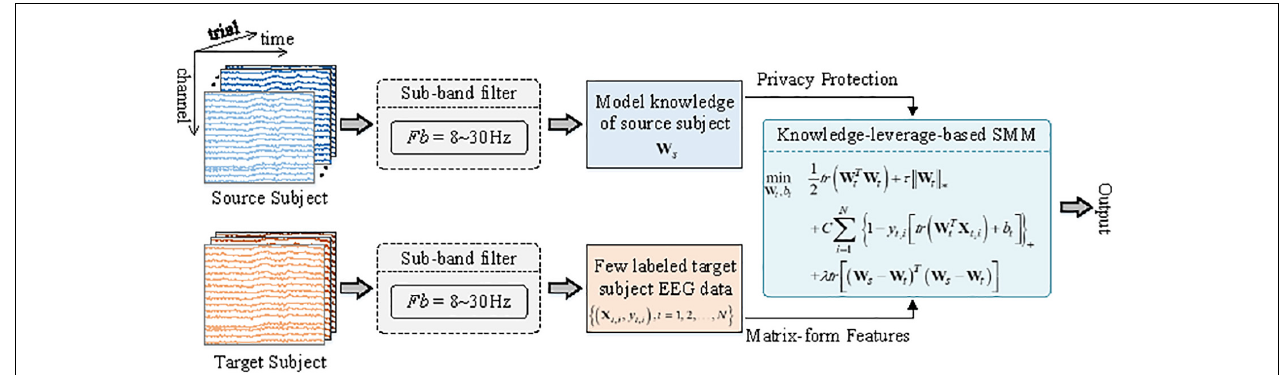
FIGURE 1 | Framework of the proposed KL-SMM for EEG-based motor imagery BCI. Both source EEG data and target EEG data are first bandpass filtered in the frequency range of 8 ∼ 30 Hz. SMM is then applied to learn source model W s . The source model (only needed) enables the classification model realize the privacy protection. An objective function of the proposed KL-SMM is then implemented by using the source model and the matrix-form features extracted from few labeled target data.